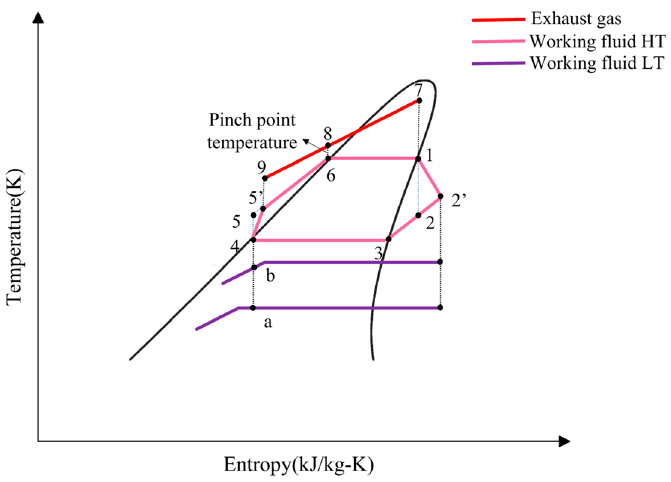
Figure 5. T-s diagram of the HT loop.